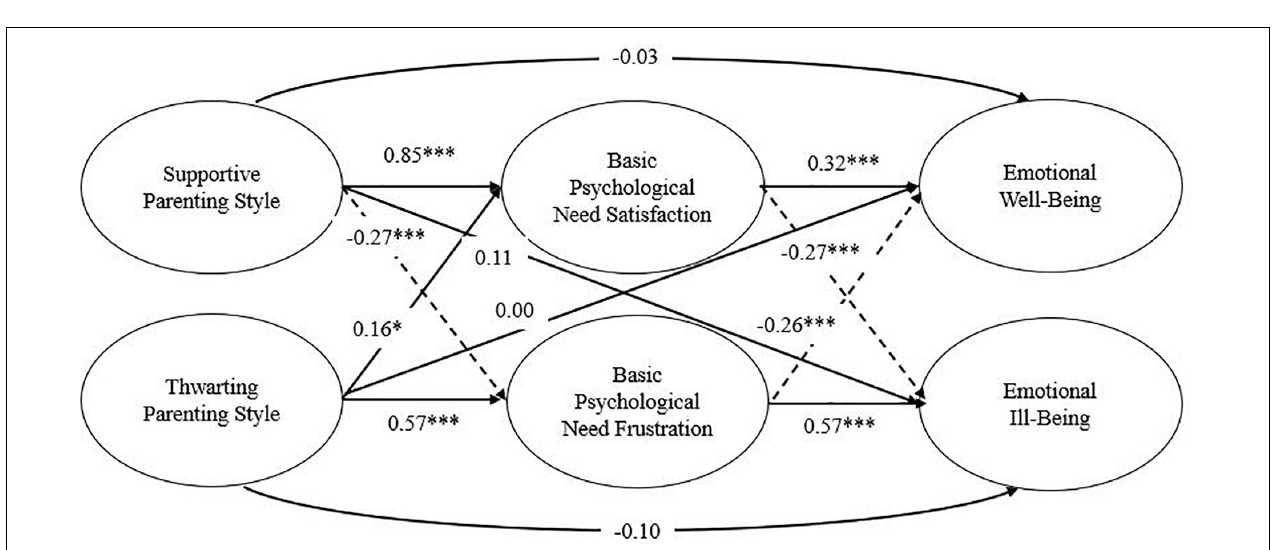
FIGURE 3 | Standardized structural equation of Model 2. Solid lines indicated positive relations, and dashed lines indicated negative relations. * p < 0.05, ** p < 0.01, *** p < 0.001.